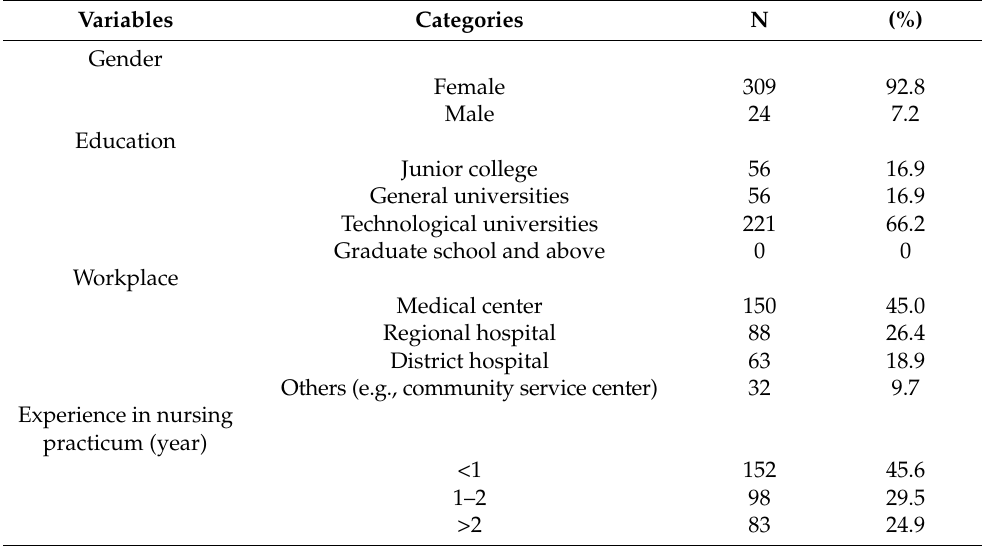
Table 1. Personal attributes of the subjects (N =